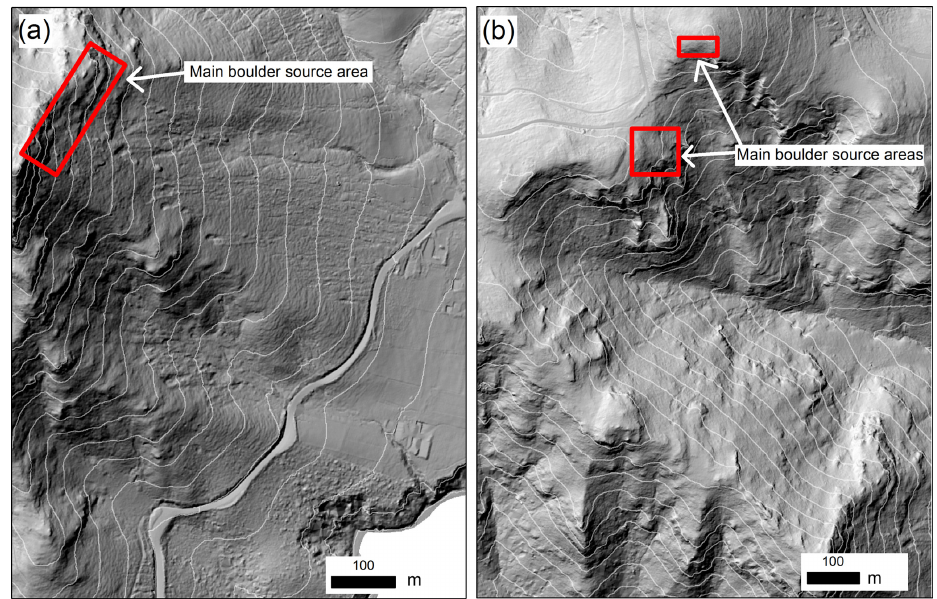
Figure 2. Hillshade topography of the Rapaki Bay (a) and Mt Vernon (b) field sites. Hillshade derived from 2015 lidar, overlaid with 20m contour intervals and showing the boulder source location for the